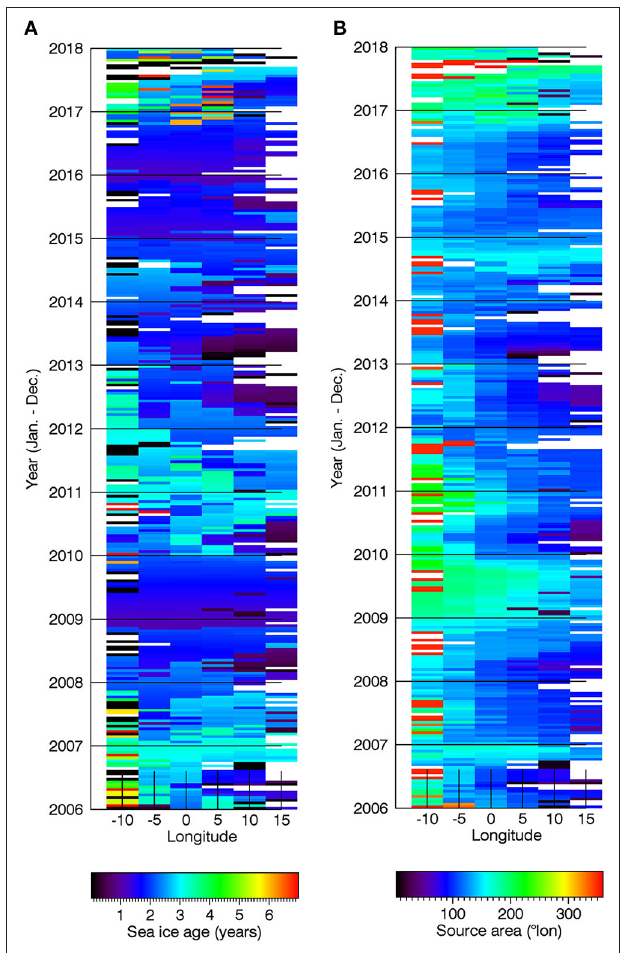
FIGURE 7 | Result of a Lagrangian approach that tracks sea ice backward in time leaving Fram Strait between 81.5 ◦ N, 10 ◦ W and 15 ◦ E (2006–2017, January–December). (A) transit time (age) of sea ice from its formation site to Fram Strait and (B) source area of sea ice exiting Fram Strait ( ◦